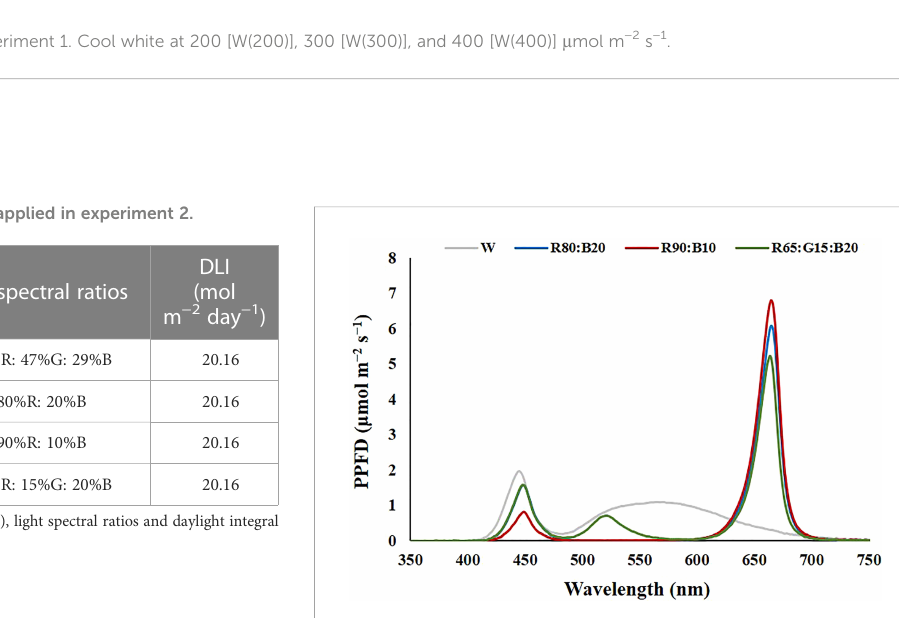
FIGURE 3 Spectrum of the light treatments applied in experiment 2. 100% cool white (W), 80% Red:20% Blue (R80:B20), 90% Red:10% Blue (R90: B10) and 65% Red:15% Green:20% Blue